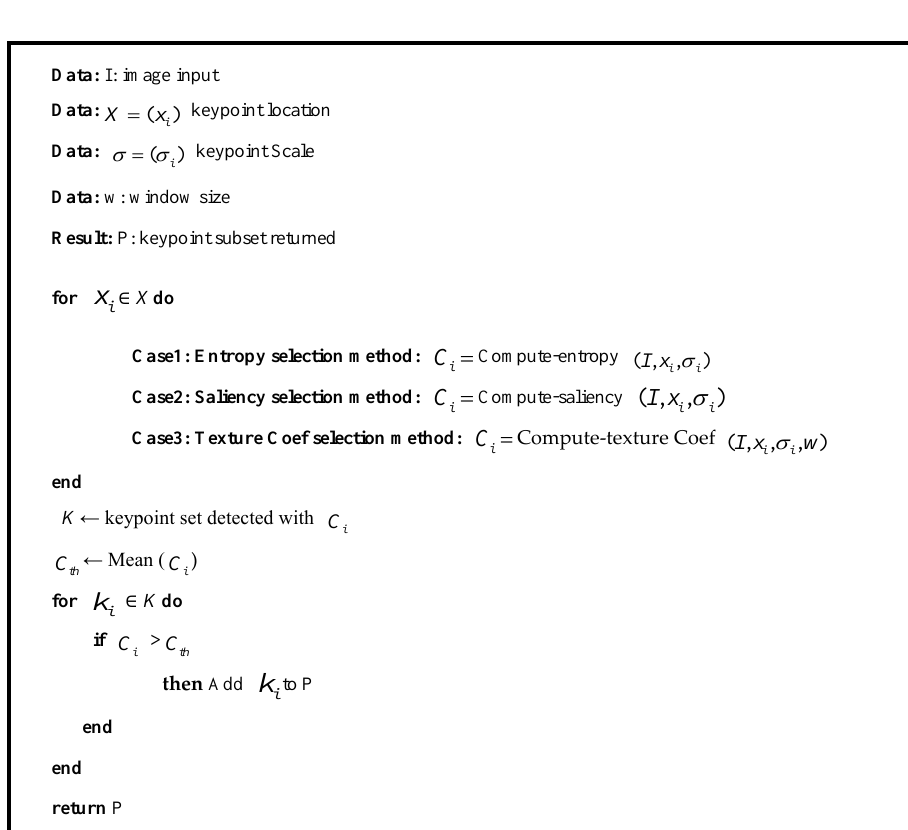
Figure 1. The pipeline of image keypoint selection and matching for the synthetic dataset.